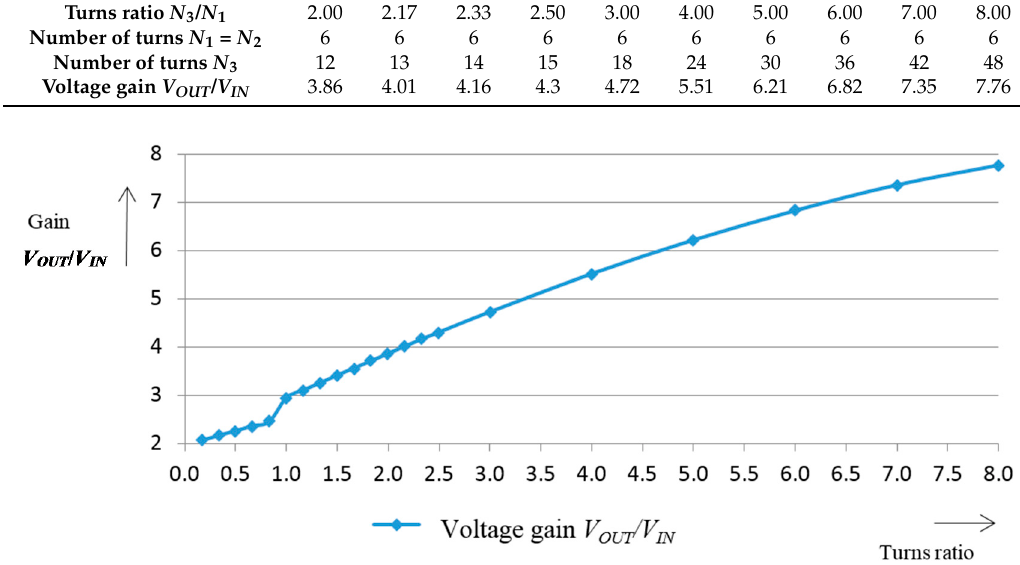
Figure 22. Dependency of converter’s voltage gain on the turns ration between L 1 = L 2 and L 3 .